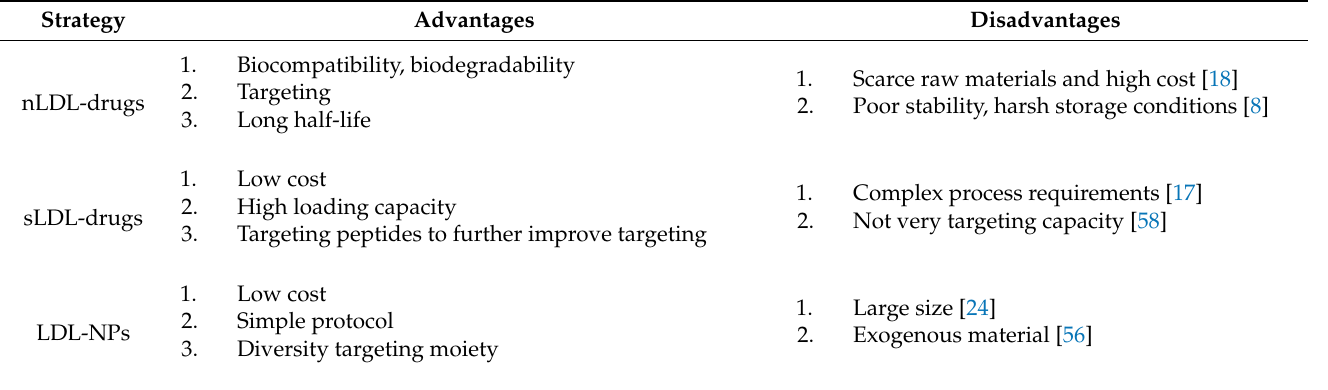
Table 5. Comparison of LDL-based